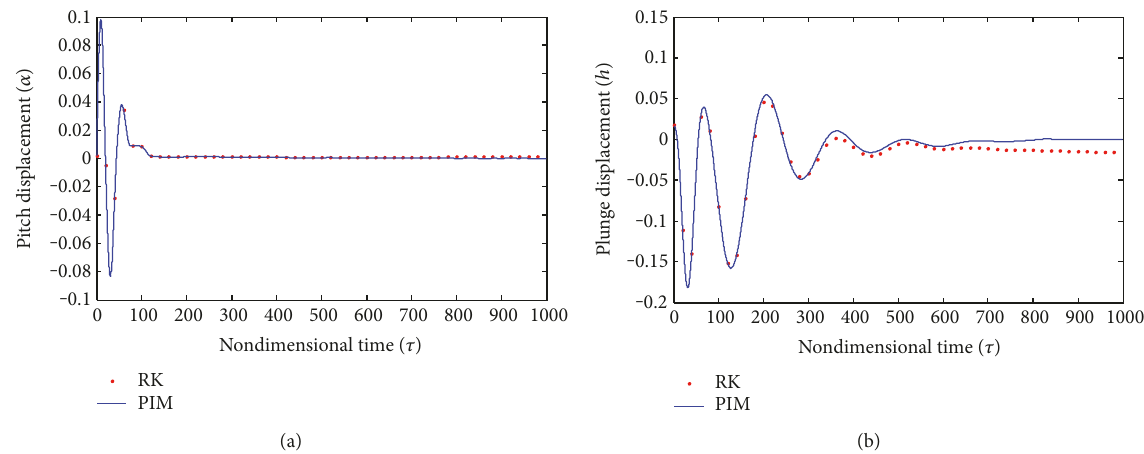
Figure 9: Time histories of the aeroelastic system at U / U